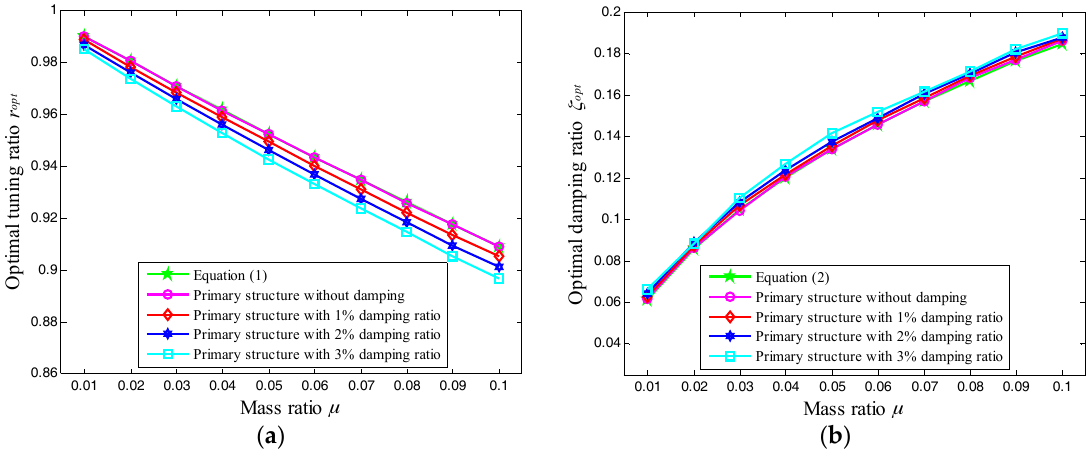
Figure 8. Optimal frequency tuning ratio r opt and damping ζ opt of a TMD for damped structure: ( a ) optimal frequency tuning ratio; ( b ) optimal damping ratio. Table 3. Optimal parameters of a TMD for the damped structure.